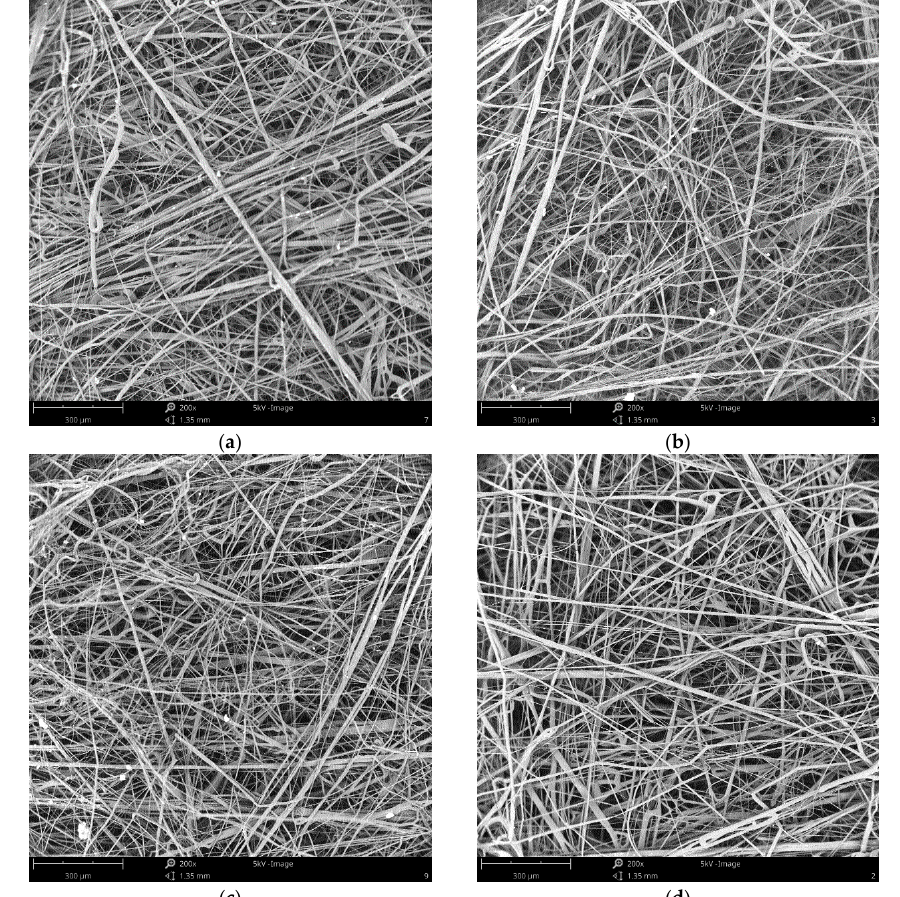
Figure 1. SEM images of electret melt-blown fabrics as related to the TiO 2 content of ( a ) 1, ( b ) 2, ( c ) 3, and ( d ) 4 wt%. Table 1. Intrinsic properties of samples made of different parameters.